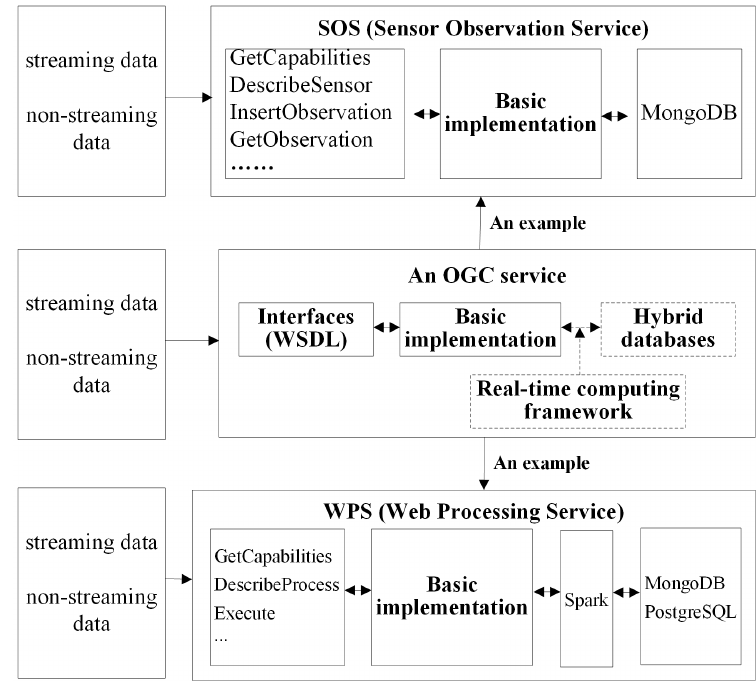
Figure 3. The architecture of a real-time computation framework and hybrid databases supported by the OGC services.